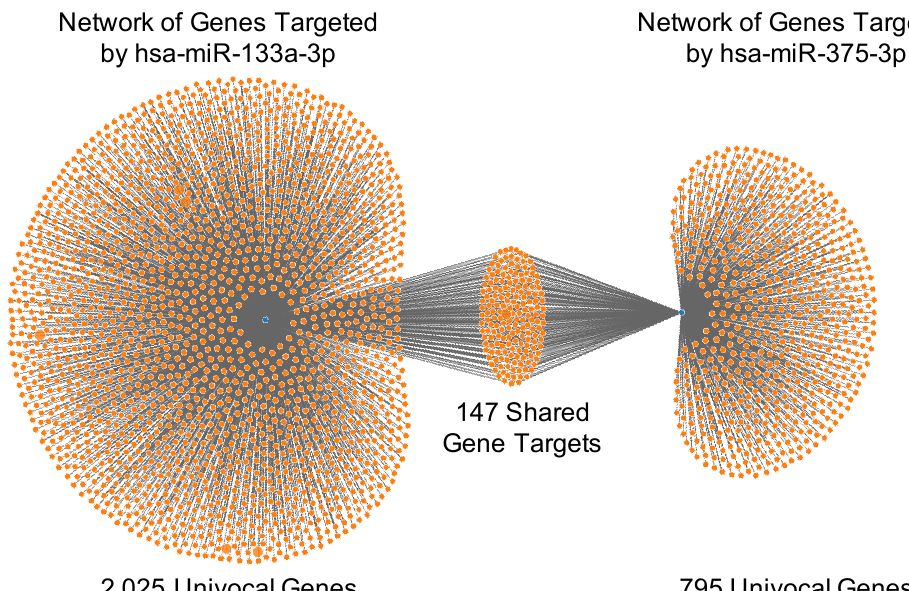
Figure 3. Network of genes targeted individually or in common by hsa-miR-133a-3p and hsa-miR-375-3p.